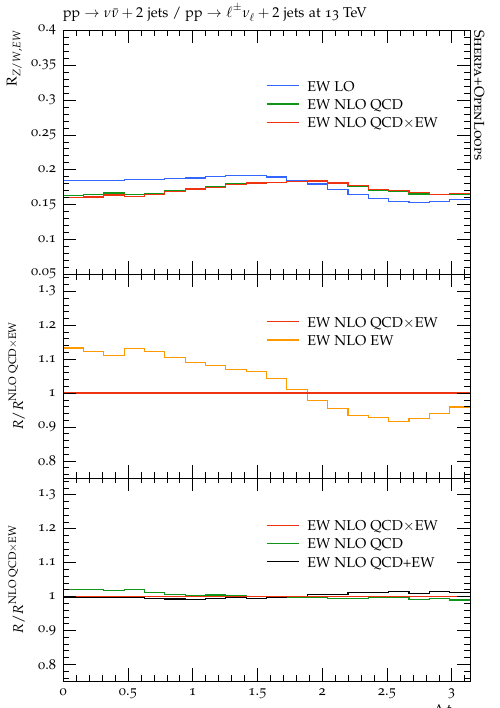
Figure 15. Ratios of the EW pp → Z ( ν ‘ ¯ ν ‘ ) + 2 jets and EW pp → W ± ( ‘ ± ν ‘ ) + 2 jets distributions in ∆ φ j without jet veto. Same higher-order predictions and conventions as in figure 1 j 2